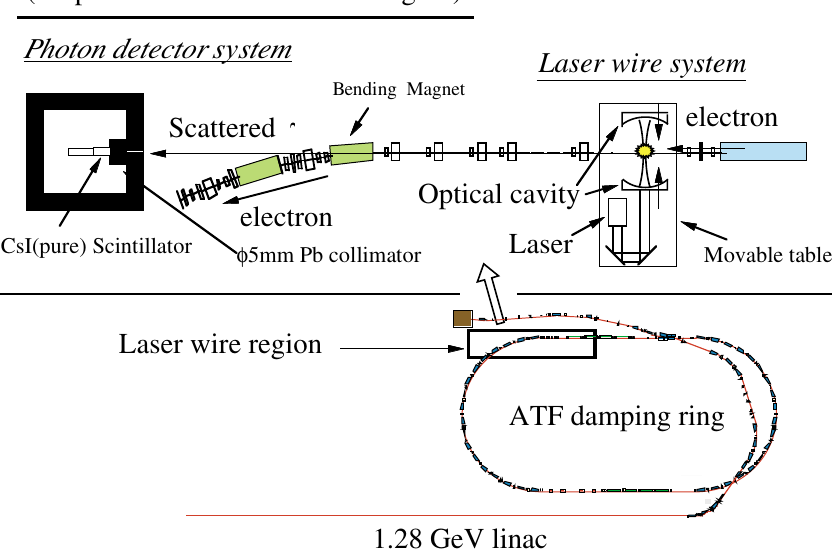
FIG. 1. (Color) Experimental setup of the emittance measurement. The laser wire monitor is installed at the north straight section of the ATF damping ring.